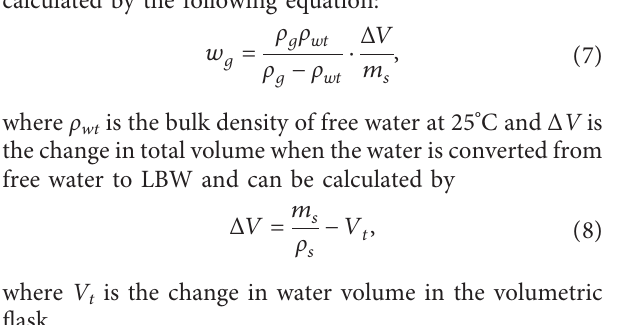
Figure 3: Compression curves of MH and SC considering different LBW densities. (a) ρ (c) ρ g � 1 . 4 g /cm 3